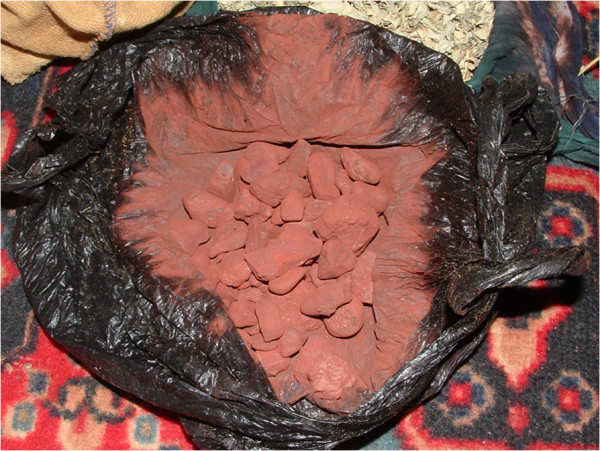
Hemera (P. Kourková).